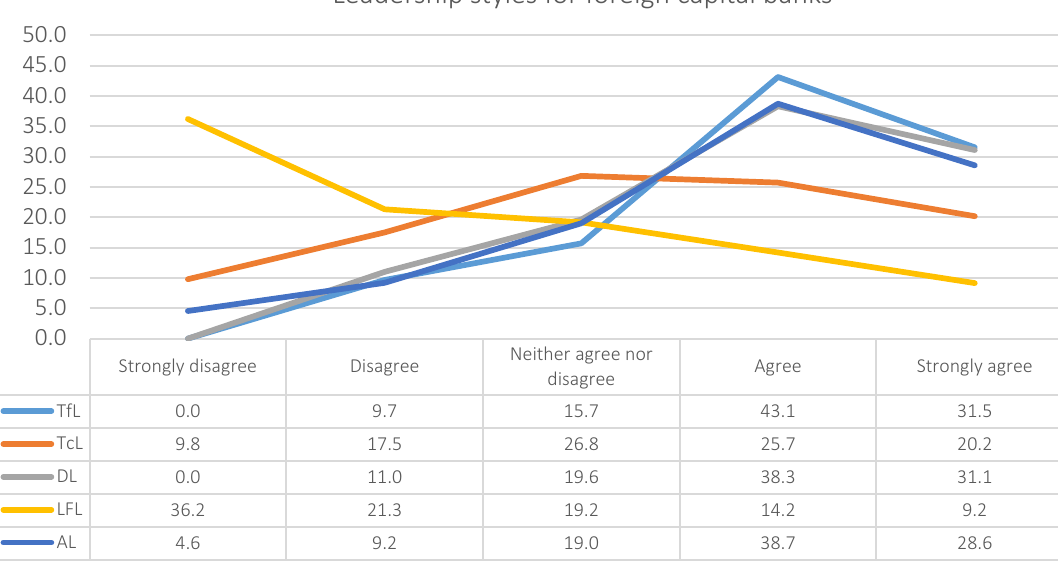
Figure 3. Leadership styles for banks with domestic capital